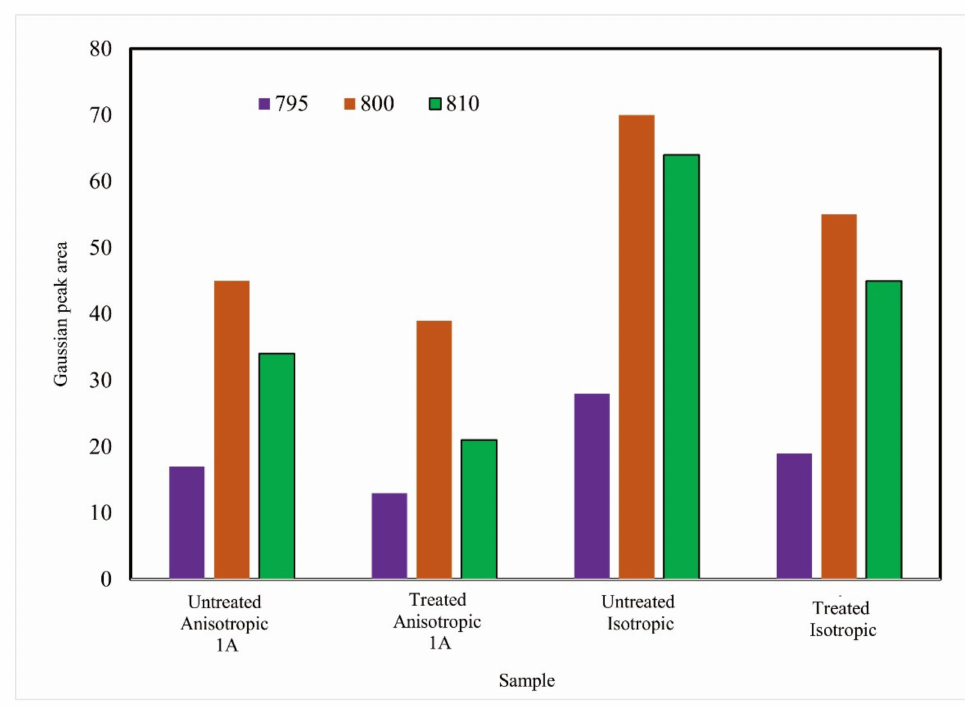
Figure 6. Gaussian peak area at 800 cm − 1 .